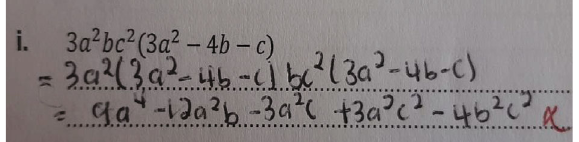
Figure 5: Control group learner X, School Y.